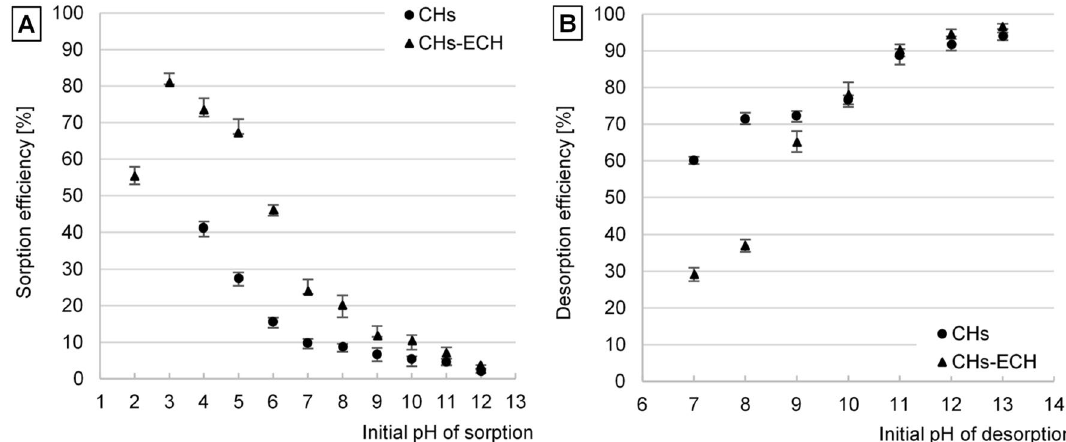
Figure 2. ( A ) Effect of pH on i-PO 4 sorption efficiency, and ( B ) Effect of pH on i-PO 4 desorption efficiency. Experiments were performed in triplicate (C start = 10 mg P-PO 4 /L, sorbent dose = 1 g d.m. /L, 150 r.p.m., temp. 22